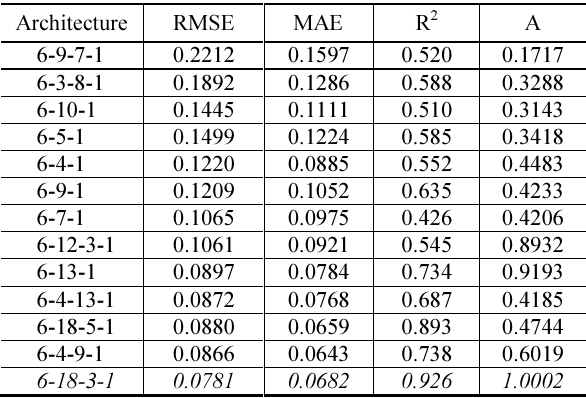
Table 2 . The value of RMSE, MAE, R line for different model’s